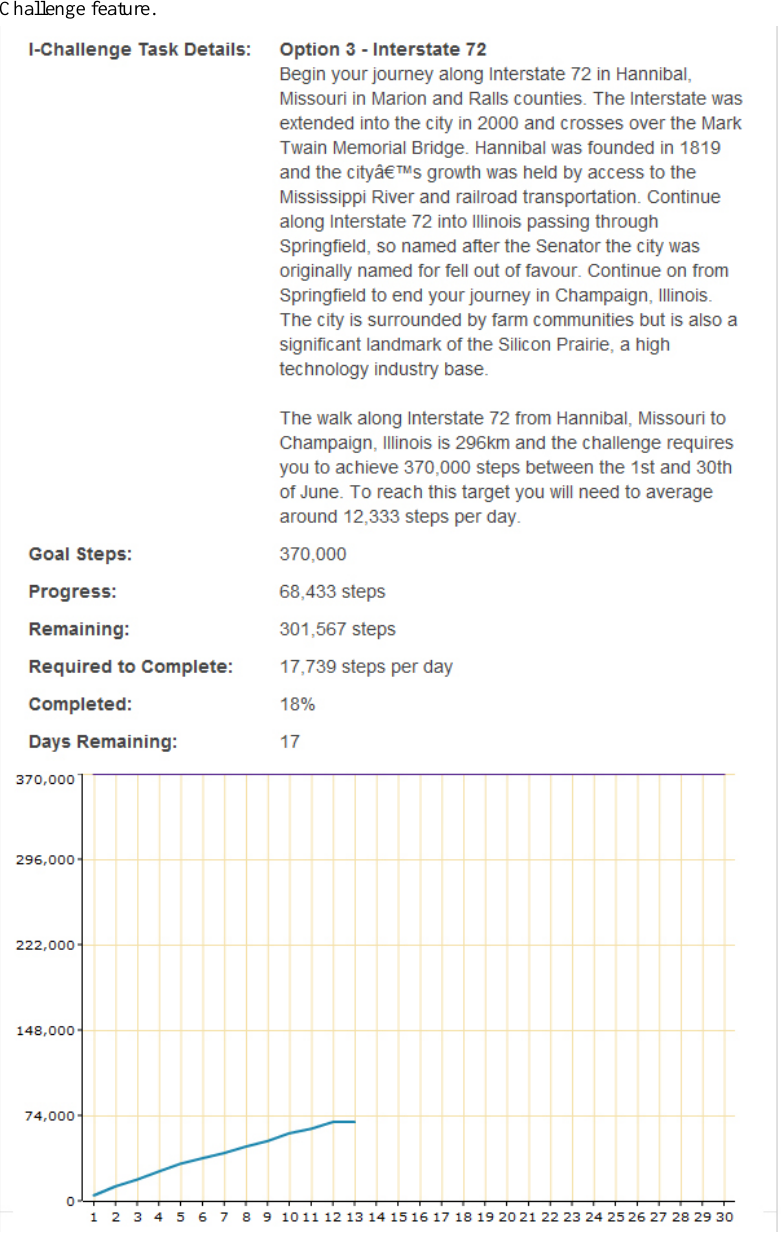
Figure 3. Screenshot of the I-Challenge